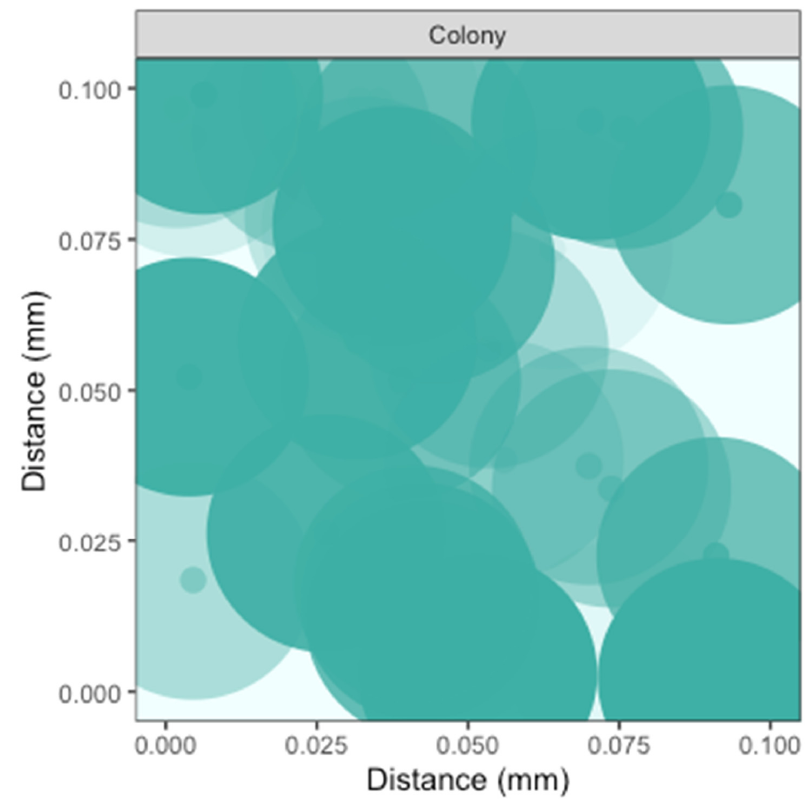
Figure 4. Simulation of [H 2 O 2 ] above seawater [H 2 O 2 ] within a Phaeocystis colony. Note the expansion of the axes scales to 0.1 mm. Cell position along a third Z axis is simulated by the ‘alpha’ with lighter cells further back.